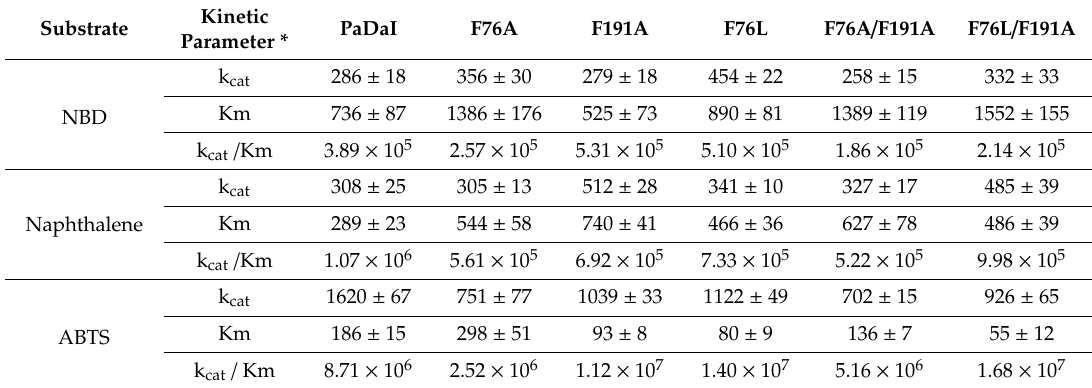
Table 1. Kinetic parameters of PaDa-I mutants for the oxidation of standard substrates (5-nitro-1,3-benzodioxole (NBD) and 2,2 (cid:48) -azino-bis(3-ethylbenzothiazoline-6-sulfonic acid (ABTS)) and